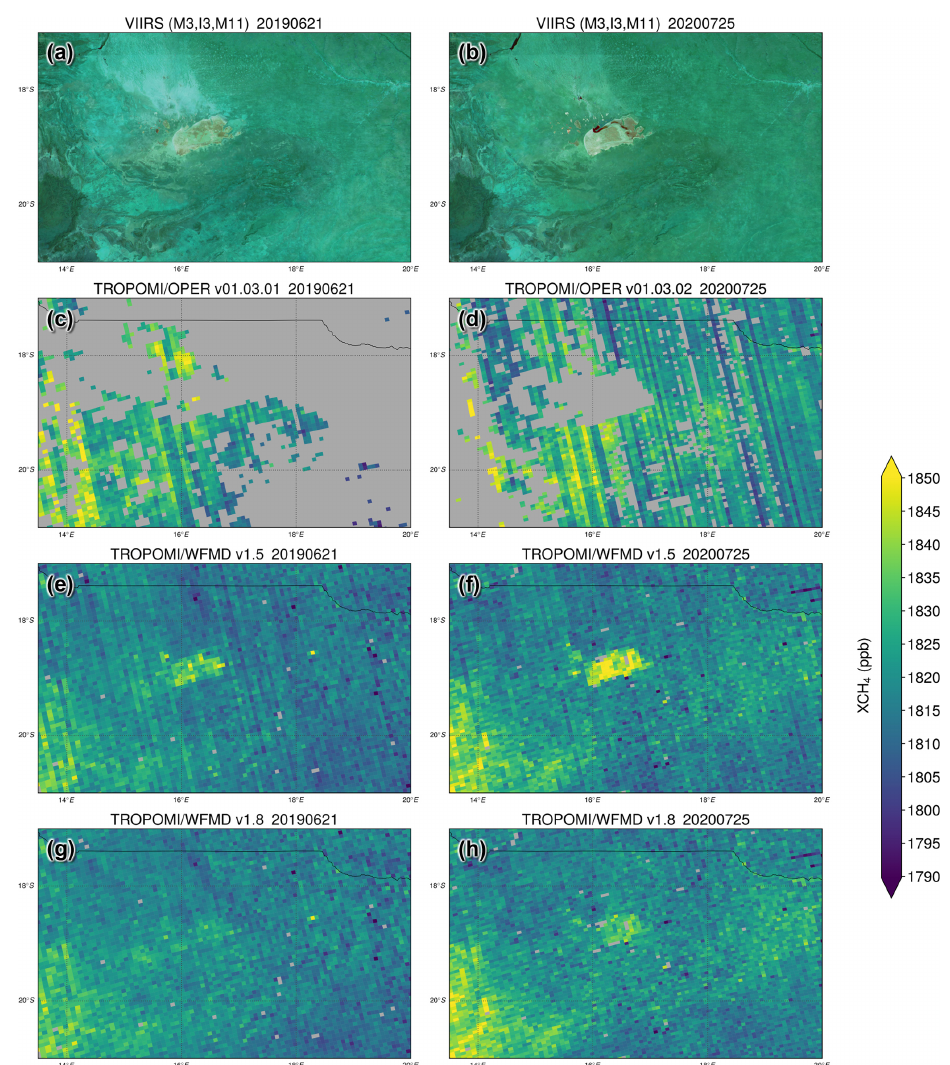
Figure 4. Comparison of a (a–b) VIIRS false colour band combination distinguishing different water states (taken from the NASA Worldview application) with the XCH 4 distribution over the Etosha Pan for (c–d) the operational product, (e–f) TROPOMI/WFMD v1.5, and (g– h) TROPOMI/WFMD v1.8 on two different days (a, c, e, g) without and (b, d, f, h) with shallow inundation of parts of the pan, which appear dark in the VIIRS false colour image. In the latter case there is a perceivable enhancement in the swamped portion for v1.8, which does not arise on the drained day. Please note that for v1.8 an additional destriping algorithm has been applied (see Sect.